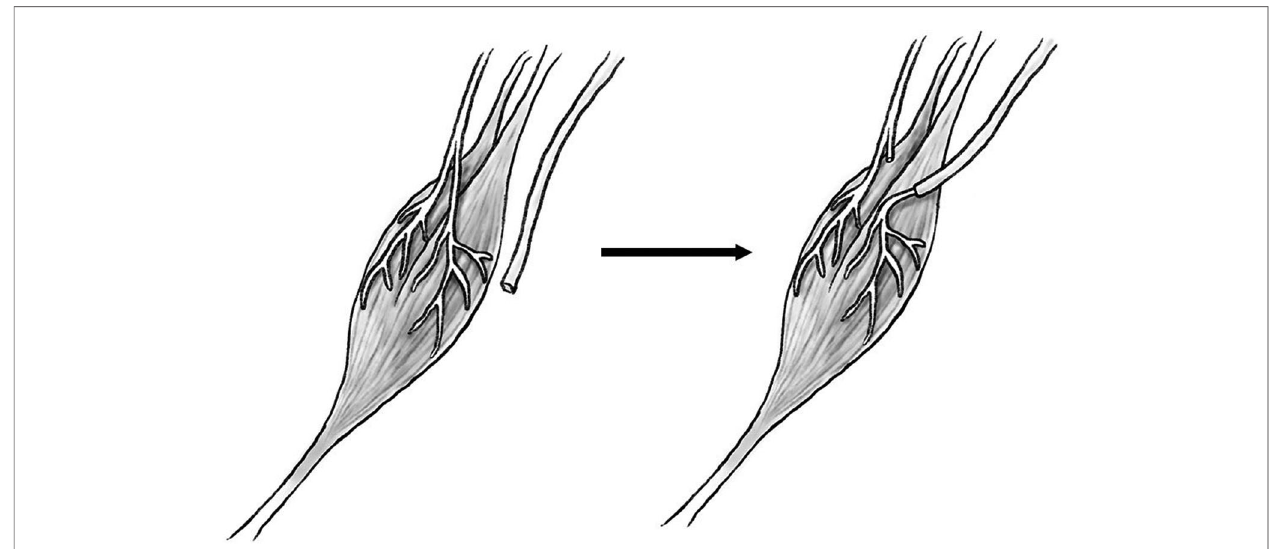
FIGURE 5 | Diagram of transected proximal nerve stump (left) transferred to motor nerve of muscle (right).